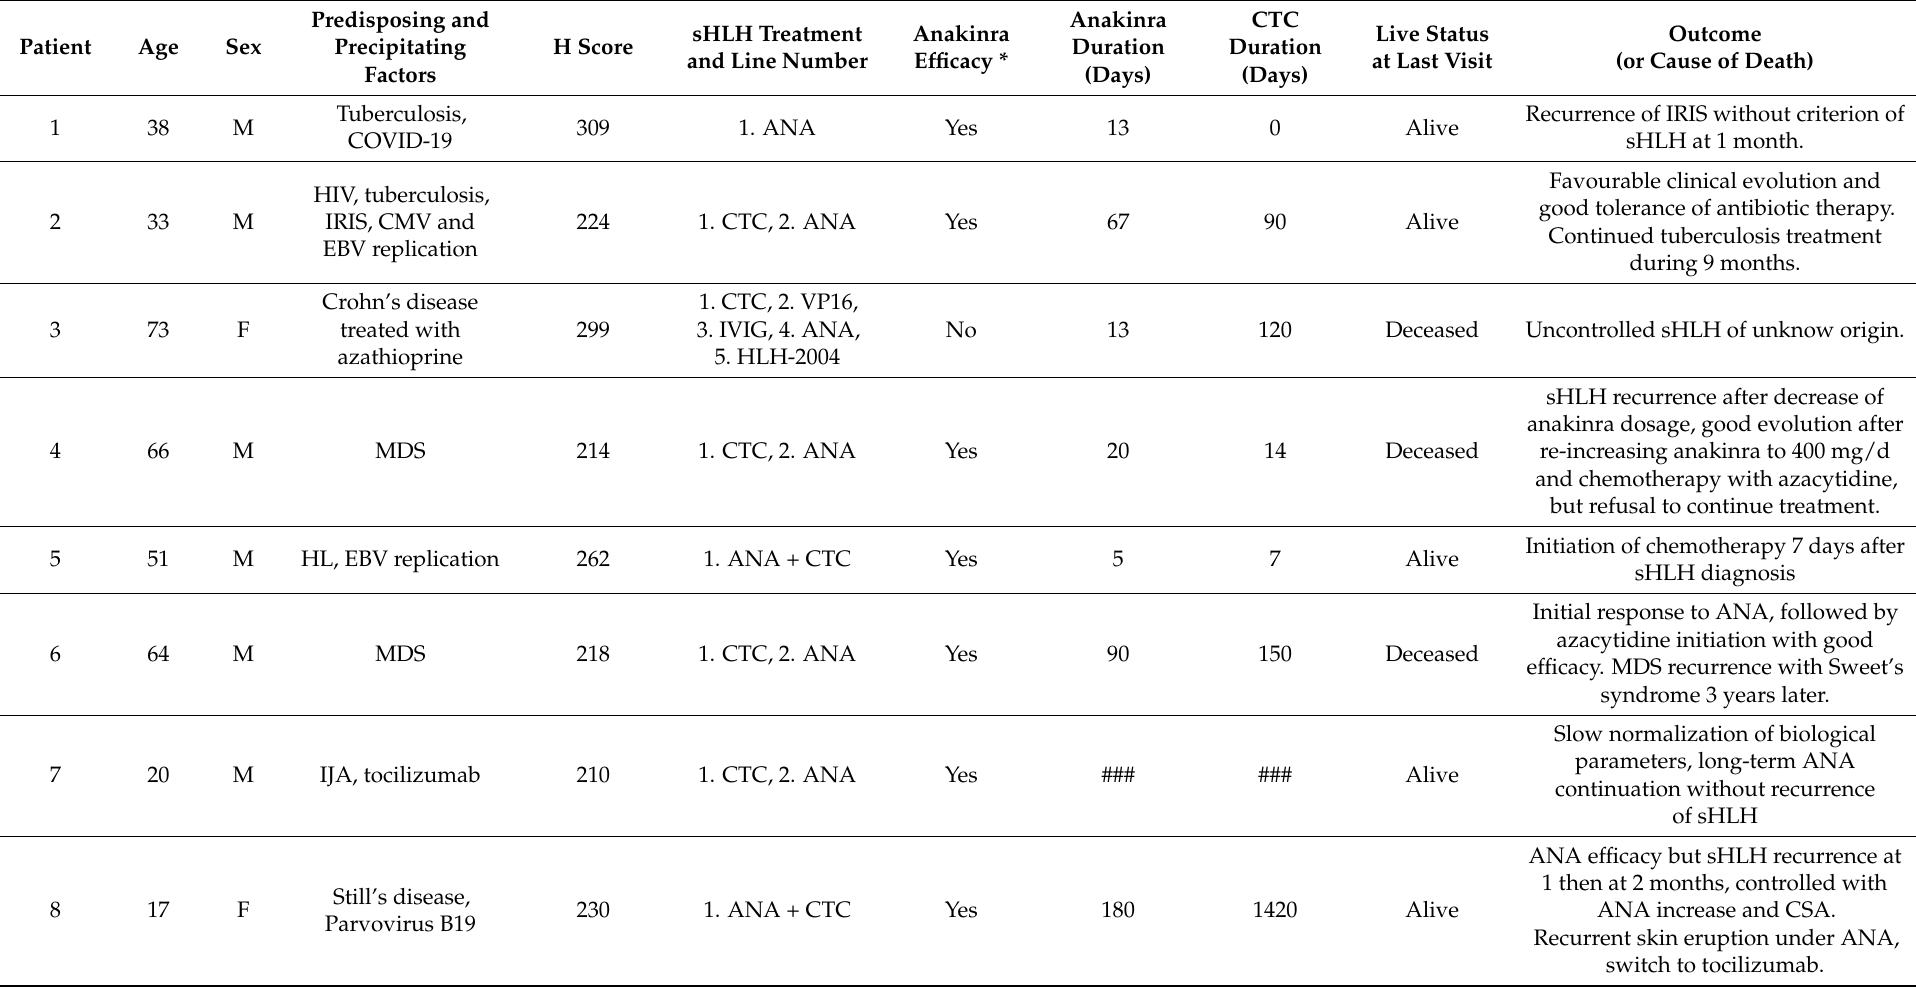
Table 2. Patients’ characteristics and